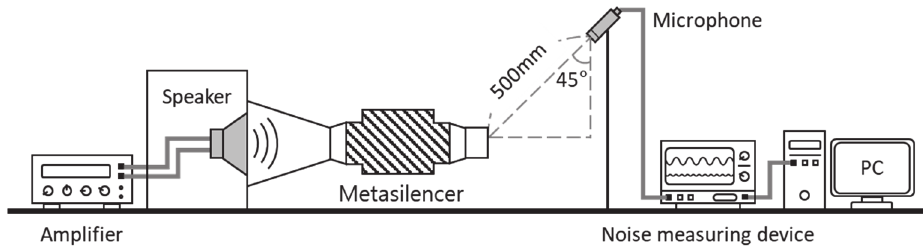
Figure 9. Schematic of speaker test setup.